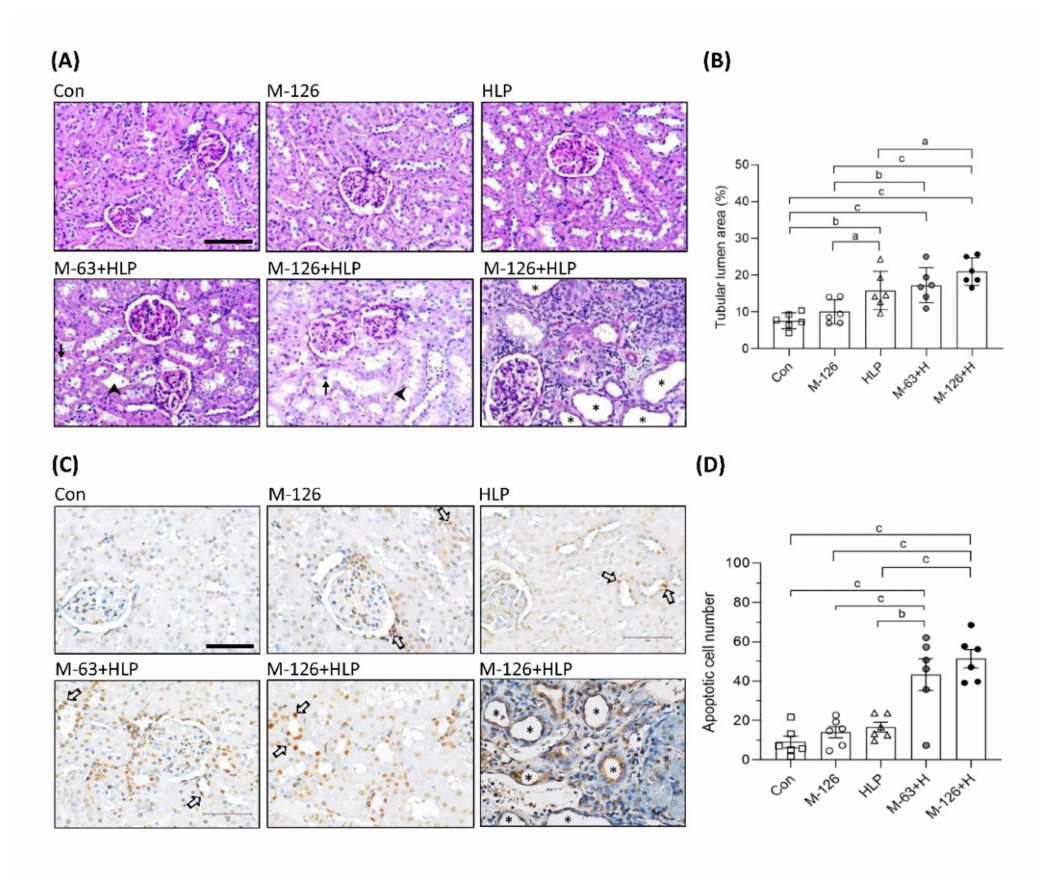
Figure 4. Morphological change and cell apoptosis in kidneys of the SD rats. ( A ) Representative images of periodic acid–Schiff (PAS) staining in kidneys of the rats. (cid:222) indicates shedding of cell nuclei. (cid:228) indicates interstitial infiltration of inflammatory cells. Scale bar = 100 µ M. ( B ) Quantified results for the renal tubular lumen area from the images of PAS staining. ( C ) Apoptotic cells in kidneys of the rats detected by TUNEL assay. The apoptotic cells were stained with DAB substrate (Brown color). (cid:233) indicates some representative apoptotic cells in renal tubules. Scale bar = 75 µ M. ( D ) Quantified results for the apoptotic cells. Cell nuclei were stained with hematoxylin. Stars indicate atrophy of renal tubules. Con: control; HLP or H: 2% hydroxy-L-proline; M-126: melamine 126 mg/kg/day; M-63: melamine 63 mg/kg/day. Data are mean ± SE from six rats of each group in the third batch animal experiment. a: p < 0.05; b: p < 0.01; c: p <